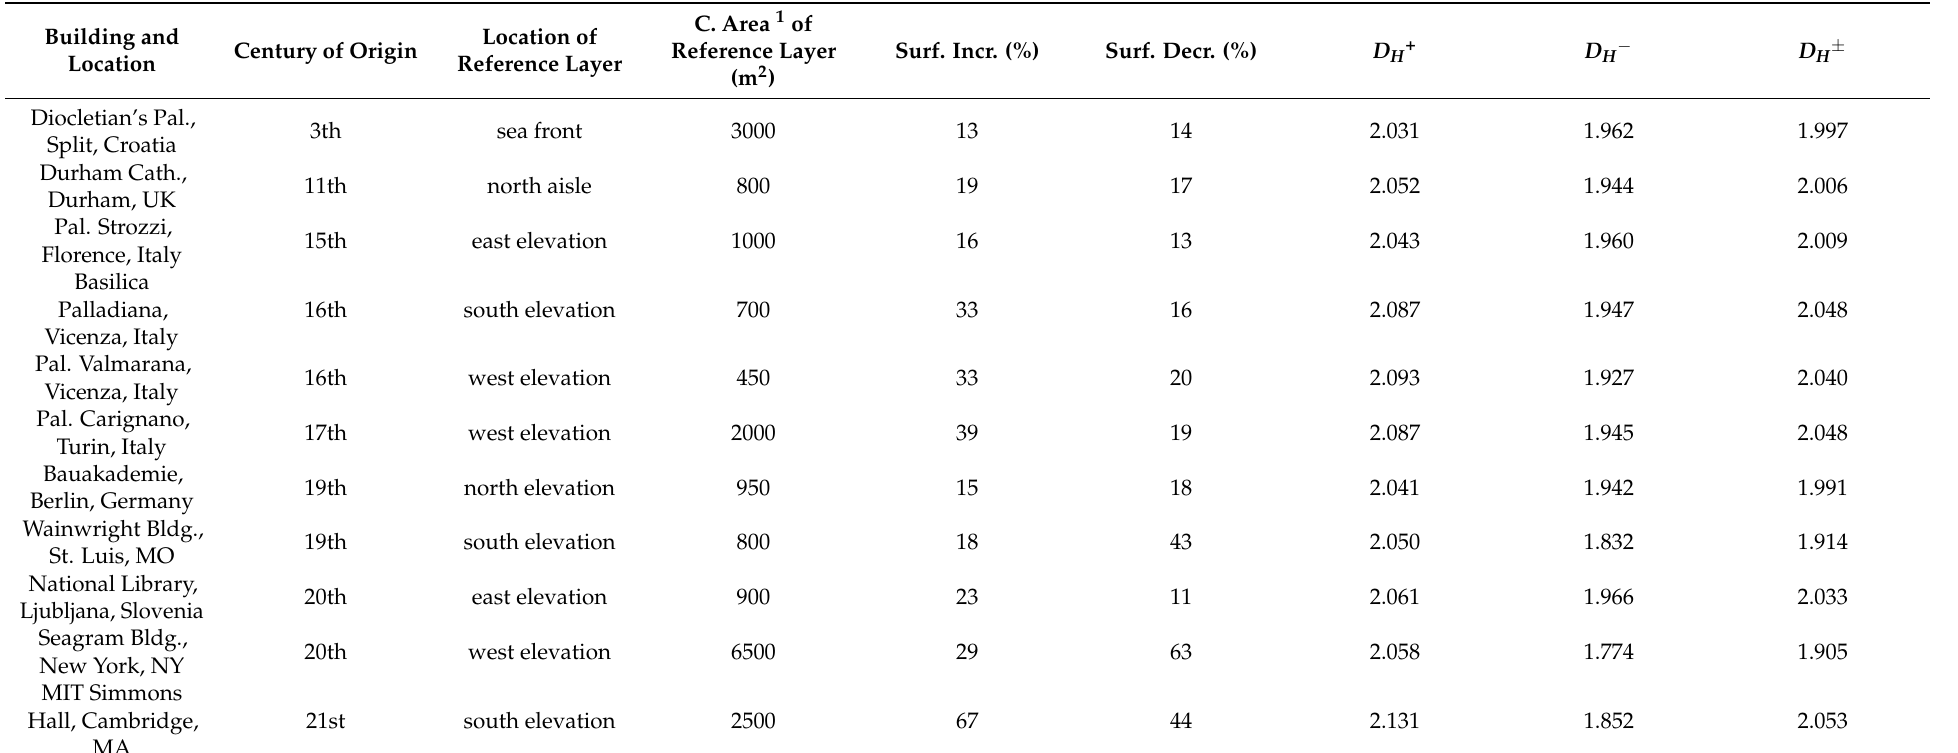
Table 3. The Hausdorff dimensions of the façades of some historical and contemporary buildings. Surface measurements were made through architectural plans, photography, and Google Earth data.